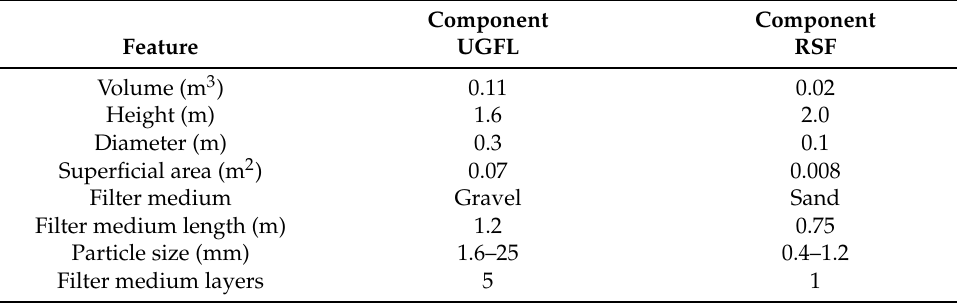
Figure 1. Sketch of the simplified pilot-scale water purification system. Table 1. Main features of UGFL and RSF. Component